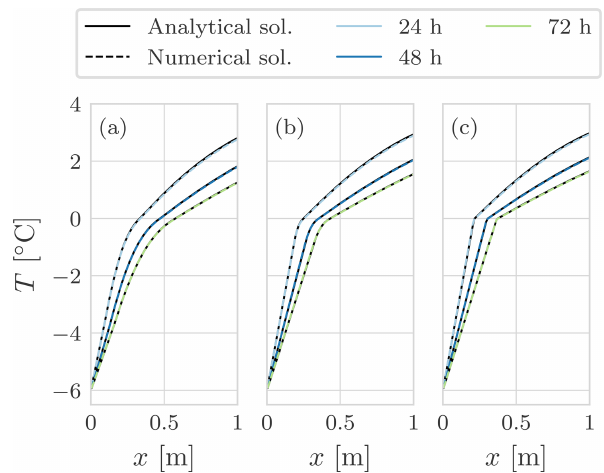
Figure 9. Comparison between the Lunardini solution and the nu- merical solution with the NCZ algorithm for the three cases of the T1 benchmark: (a) T m = − 4 ◦ C, (b) T m = − 1 ◦ C, and (c) T m = − 0 . 1 ◦ C. The colours represent different time frames. The integra- tion time step is (cid:49)t = 3600s, and the space resolution is (cid:49)x = 0 . 01m.